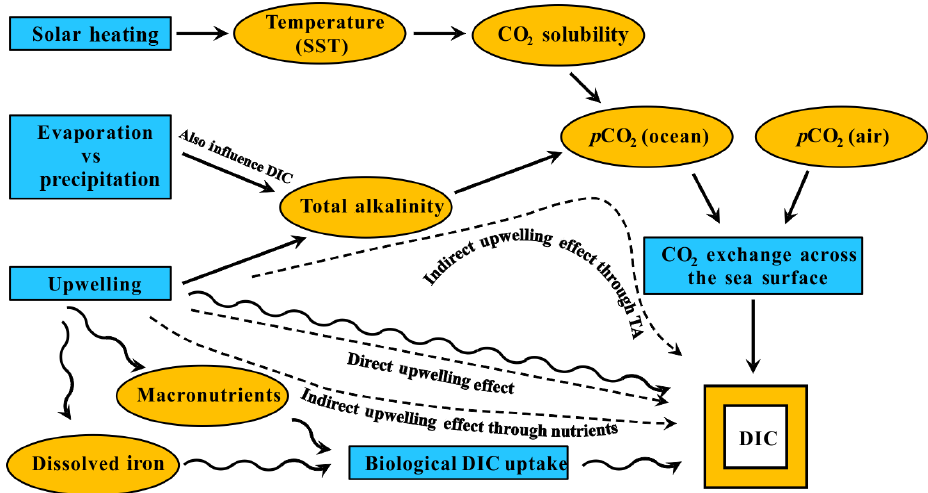
Figure 2. Major controls on surface DIC. Schematic showing the main processes exerting an influence over the concentration of DIC in the global surface ocean (producing variation with latitude). Blue shapes are processes and orange shapes are variables. Straight solid arrows represent equilibrium processes regulating DIC in the long term and wavy solid arrows represent disequilibrium processes regulating DIC in the short term. In the paper, we evaluate the upwelling effect on surface DIC in the Southern Ocean. Dashed arrows with text denote the three different ways that upwelling affects DIC: the direct effect through upwelled DIC, the indirect effect through upwelled nutrients which stimulate biological removal of DIC, and the indirect effect through upwelled TA changing the equilibrium DIC with the